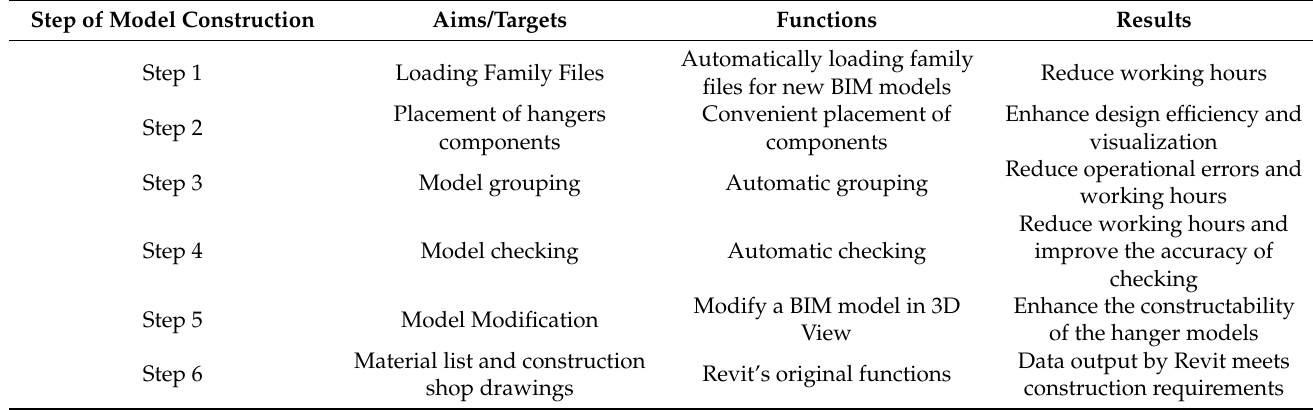
Table 2. Results of the individual steps of model